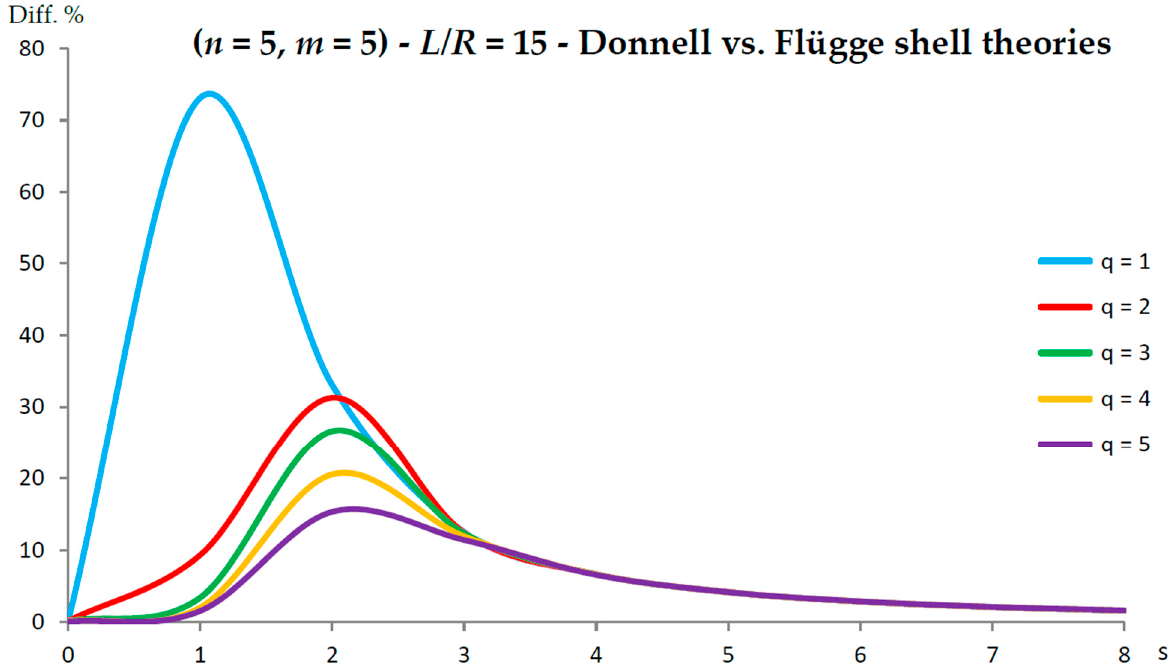
Figure 8. Percentage differences between the radial natural frequencies obtained via Donnell and Flügge shell theories (Flügge as the reference). Anisotropic elastic shell model. Simply supported SWCNT of Table 1 with chirality indices (𝑛 = 5, 𝑚 = 5) and aspect ratio 𝐿/𝑅 = 15 . Number of longitudinal half-waves 𝑞 . Number of circumferential waves 𝑠 .